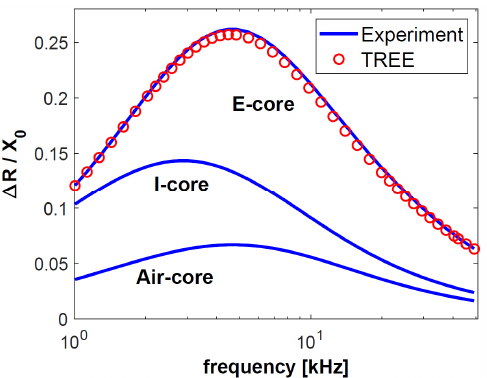
Figure 6. The changes in the resistance Δ R normalised with respect to the reactance X 0 for sample made of brass and copper.